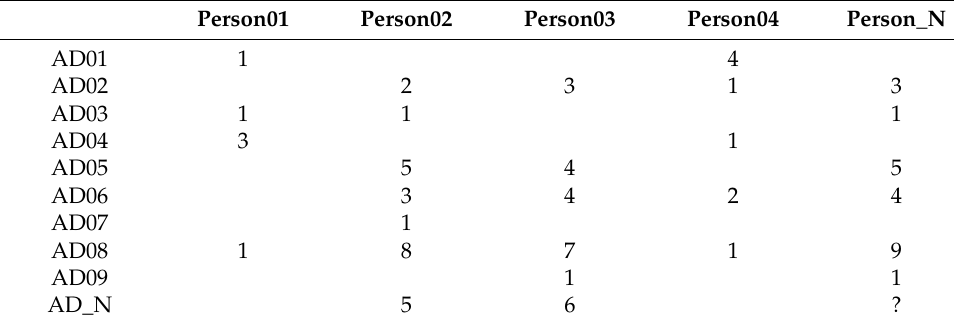
Table 12. The audiences’ preference for different advertising items.